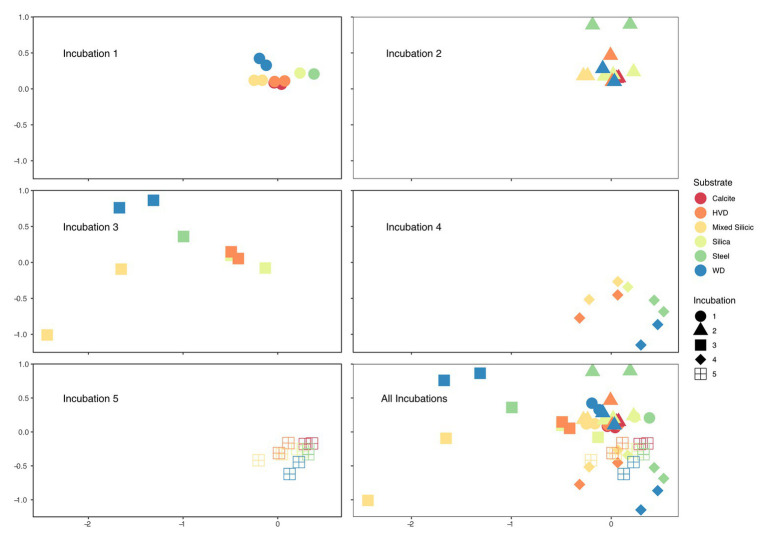
Faceted non-metric multidimensional scaling (NMDS) of microbial relative abundance on solid substrates used in each Incubation with combined NMDS bottom right. Each point on the plot represents an individual cartridge from an incubation; two points of the same color and shape are biological replicates of substrates from the same incubation but incubated in separated cartridges in situ. Incubations 1 and 2 are the most closely related and both occurred before the addition of the organic carbon substrate. Incubation 3 represents the first samples obtained after the carbon amendment and displays the widest variation amongst biological replicates and amongst mineral substrates. Incubation 4 is dominated by methanogenic archaea which pulls the samples into a cluster toward the bottom, and by Incubation 5, the samples are again tightly clustered and close to their starting position on the NMDS axes.